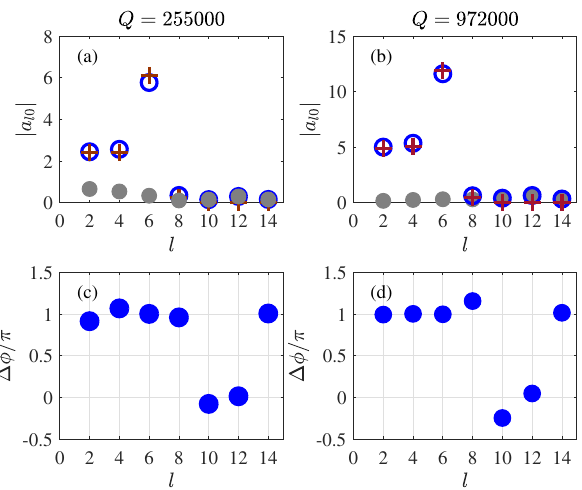
Figure 6: The multipole radiation amplitudes in Eq. (1) from DS of two dimers with slight difference in scales. (a) and (b) Modules and (c) and (d) phase difference of complex of inner and outside dimers. In (a) and (c) subplots amplitudes a l 0 h = 1 . 04 , h 1 = 1 . 02 , L = 2 . 27 , D = 0 . 66. In (b) and (d) h = 1 . 03895 , h 1 = 1 . 01727 , L = 2 . 2731 , D = 0 .